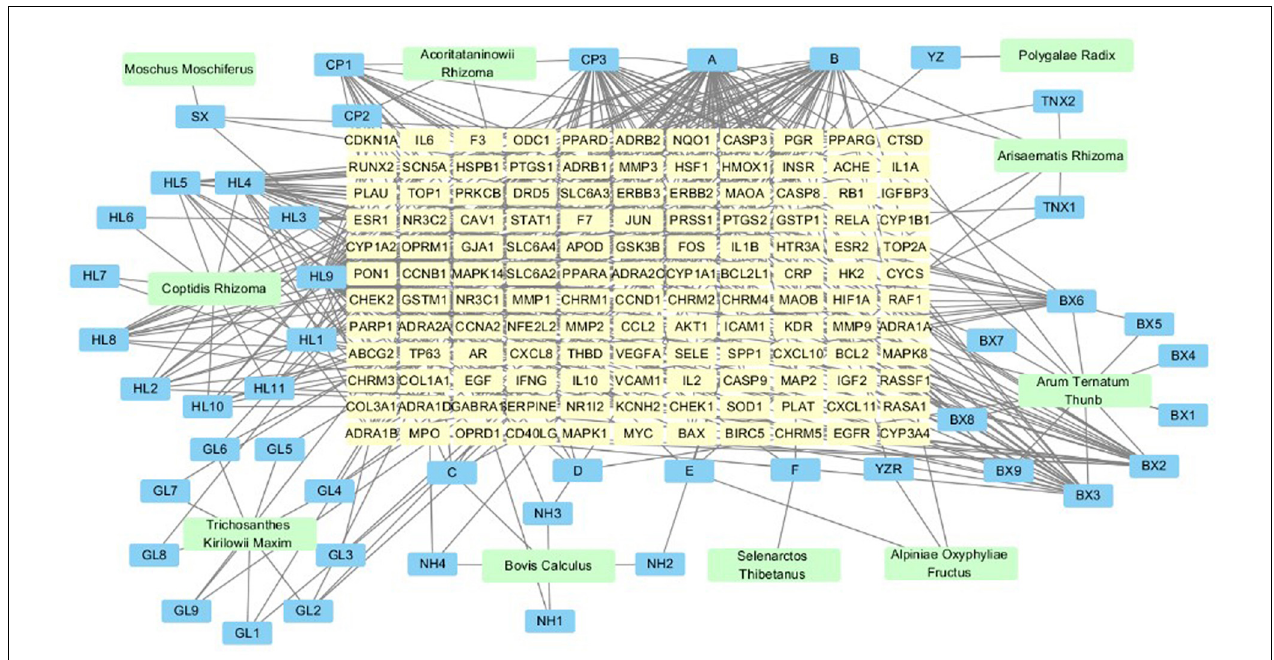
FIGURE 2 | Xingnao Kaiqiao Pill- tradition Chinese medicine—compound-common target relationship network.